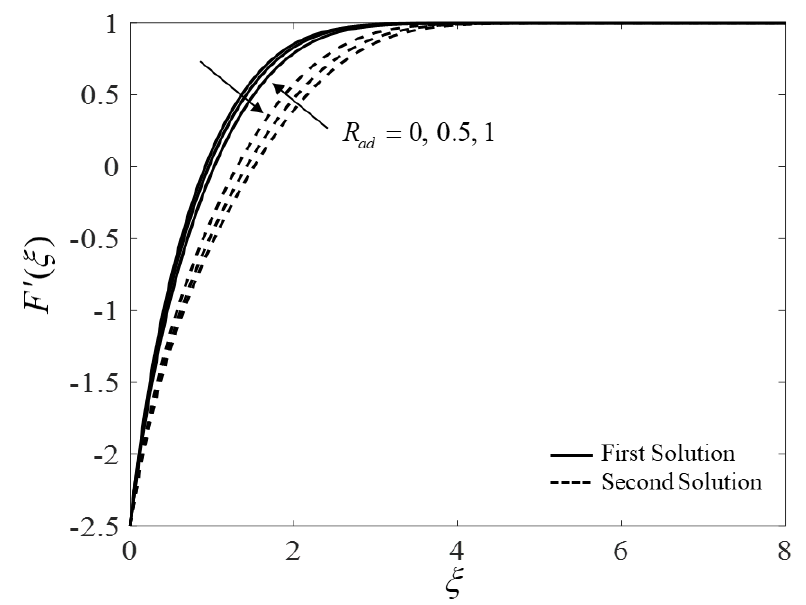
Figure 12. Velocity profile F (cid:48) ( ξ ) for different values of R ad